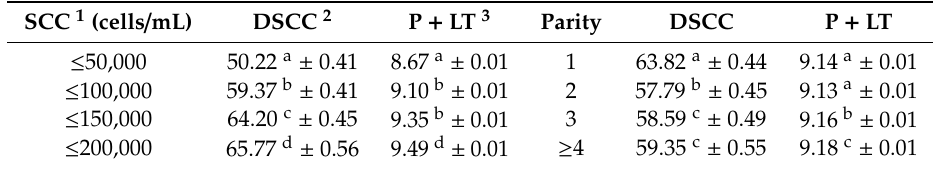
Table 3. DSCC and P + LT mean and standard error in healthy subset ranked by SCC levels and parities. SCC 1 (cells / mL)